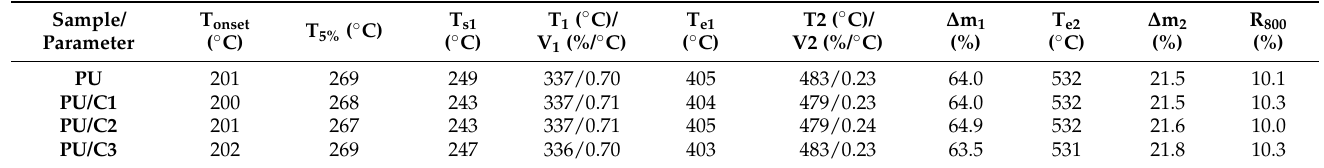
Table 7. Summary of TGA analysis